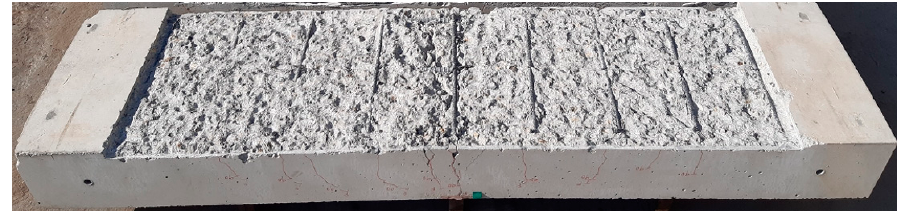
Figure 18. Damaged RC slab after removing strengthened section by chipping.